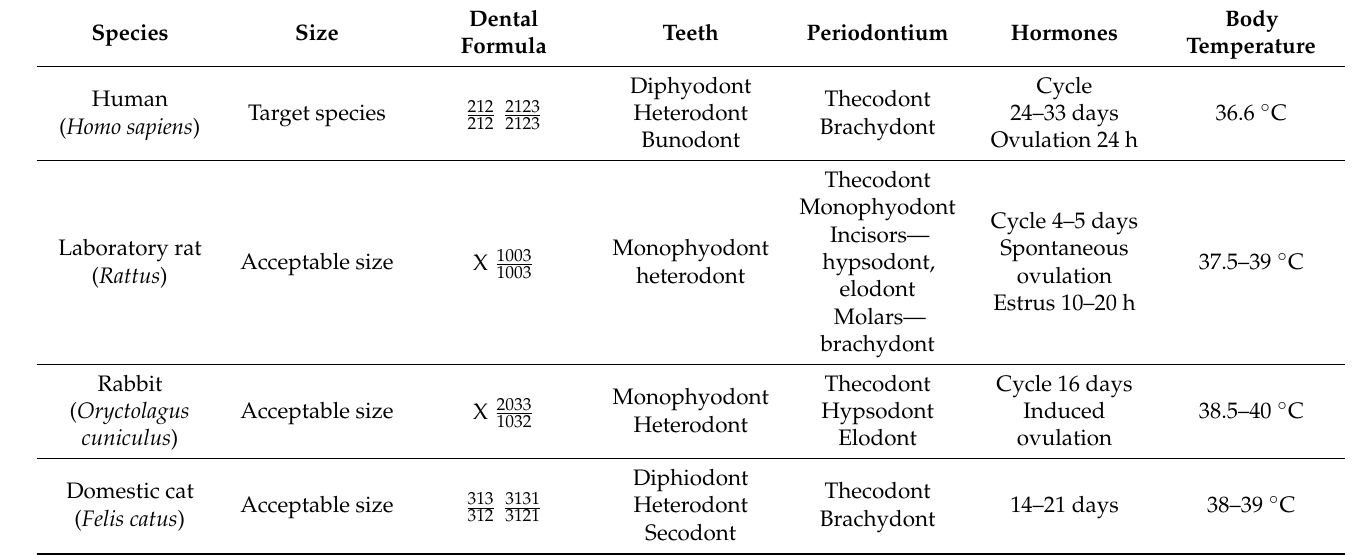
Table 2. Comparison of laboratory animals in terms of dentition, periodontium, reproductive cycle, body